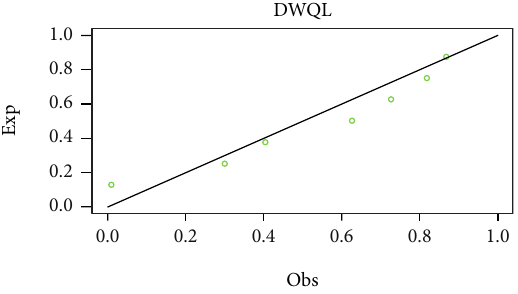
Figure 10: PP plot of the fi tted model for the fi rst data